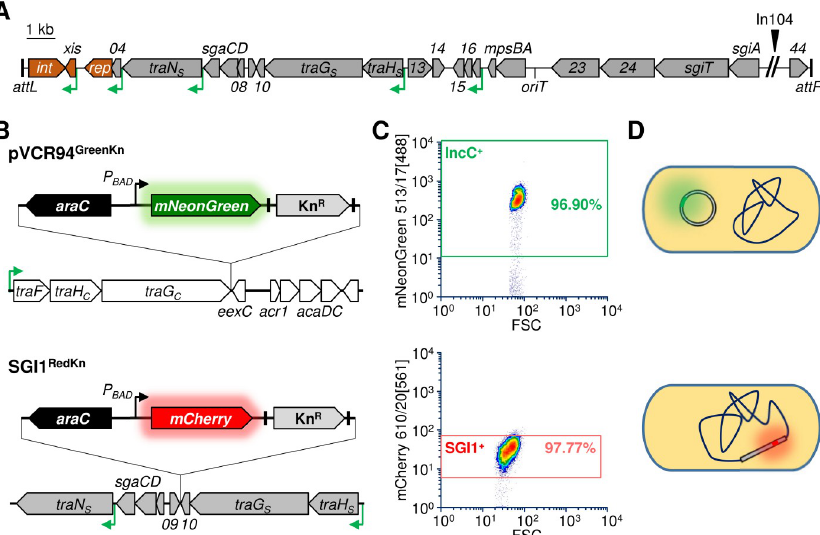
Fig 1. Monitoring of pVCR94 and SGI1 in cells by flow cytometry (FC). A. Schematic representation of chromosomally integrated SGI1. ORFs are represented by gray arrows. Gene numbers correspond to the last digits of locus tags S0xx in the Genbank accession number AF261825. ORFs of interest in this work are shown in brown. AcaCD binding sites are depicted by green angled arrows. Left ( attL ) and right ( attR ) junctions with the chromosome are indicated by black bars at the ends. The position of the complex class 1 integron In104 (multidrug resistance region) is indicated by a black arrowhead. B. Fluorescent reporter genes mNeonGreen (green arrow) and mCherry (red promoter were inserted in pVCR94 between traG and eexC , and in SGI1 arrow) under the control of the P BAD C between S009 and S010 . C. Representative flow cytometric scatter plots of green and red fluorescence of E . coli KH95 bearing either pVCR94 GreenKn or SGI1 RedKn . D. Schematic representation of the labelled elements in the cells. SGI1 RedKn is integrated into the chromosome at the 3’ end of trmE